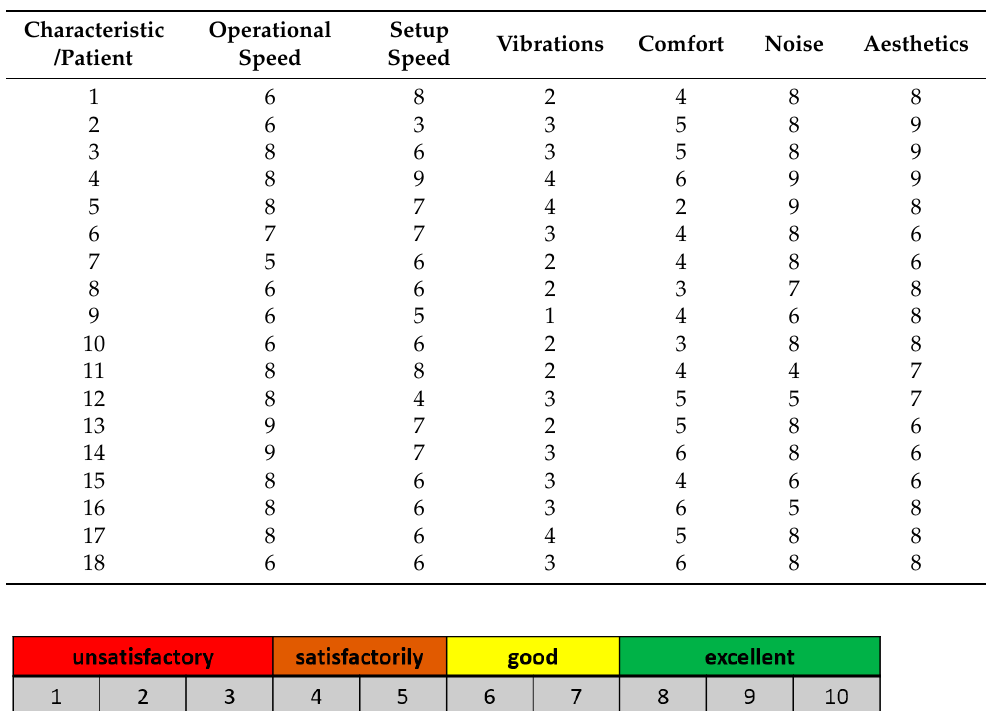
Figure 10. Snapshots from the experimental tests using ASPIRE: ( a ) flexion–extension motion and ( b ) adduction–abduction motion. Table 4. Flexion/extension module.